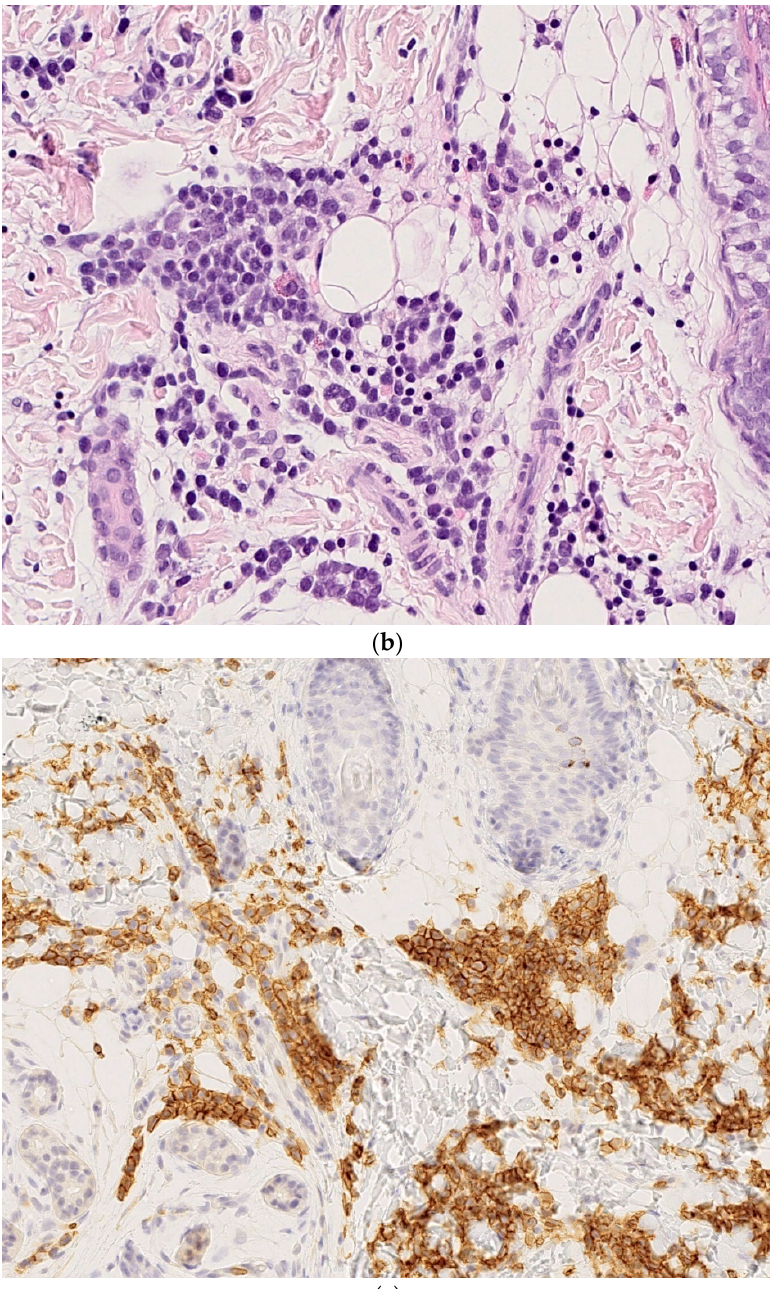
Figure 3. Dermal erythropoiesis ( a , b ) 2.5× and 25× clusters of erythroblasts in the dermis. They are highlighted by anti-glycophorin antibody ( c ).